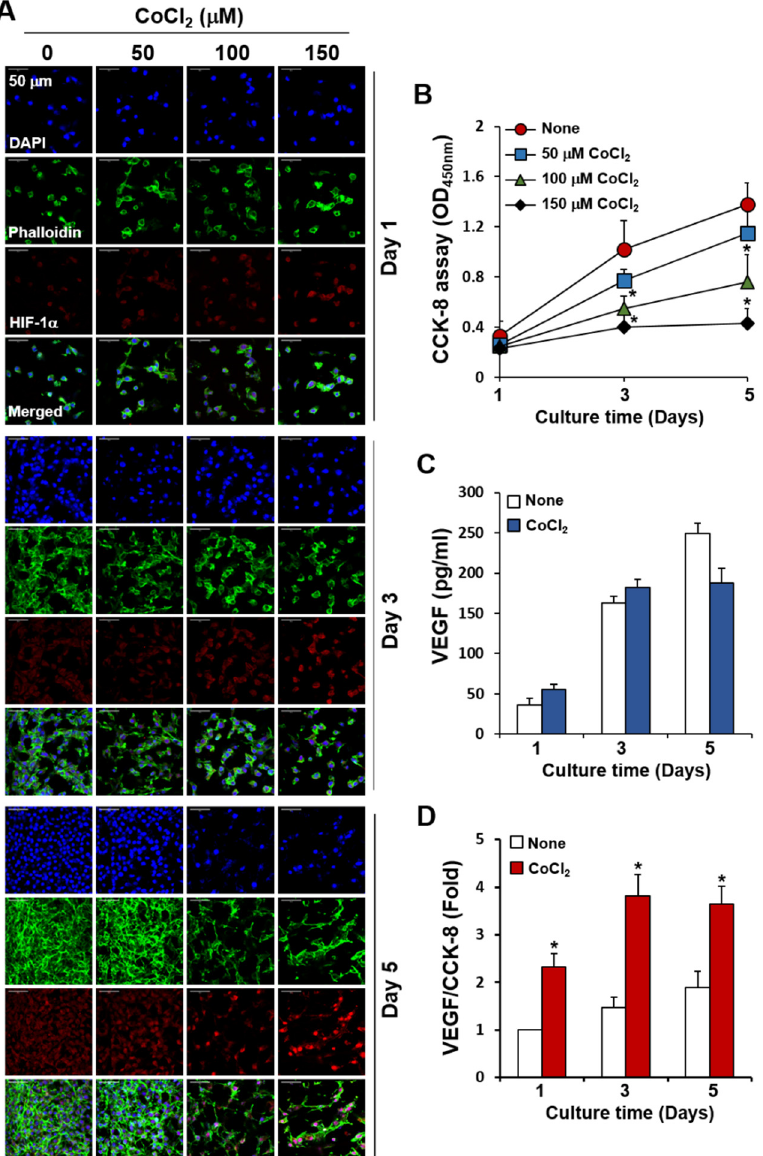
Figure 9. Decreased proliferation of CT26 cancer cells cultured on C-PCL-M and treated with CoCl 2 at high concentrations . CT26 cells (3 × 10 4 ) alone were top-seeded on C-PCL-M and cultured for the indicated periods with CoCl 2 at increasing concentrations ( n = 3). ( A ) Cells were stained with